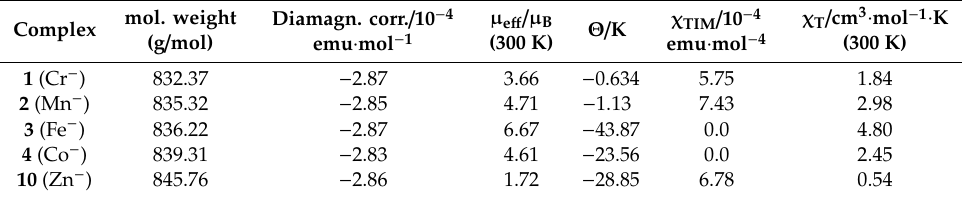
Table 5. Calculated Θ and χ TIM values for the anionic complexes 1 − 4 and 10 obtained from fitting of their variable temperature magnetic data to the Curie – Weiss Law.